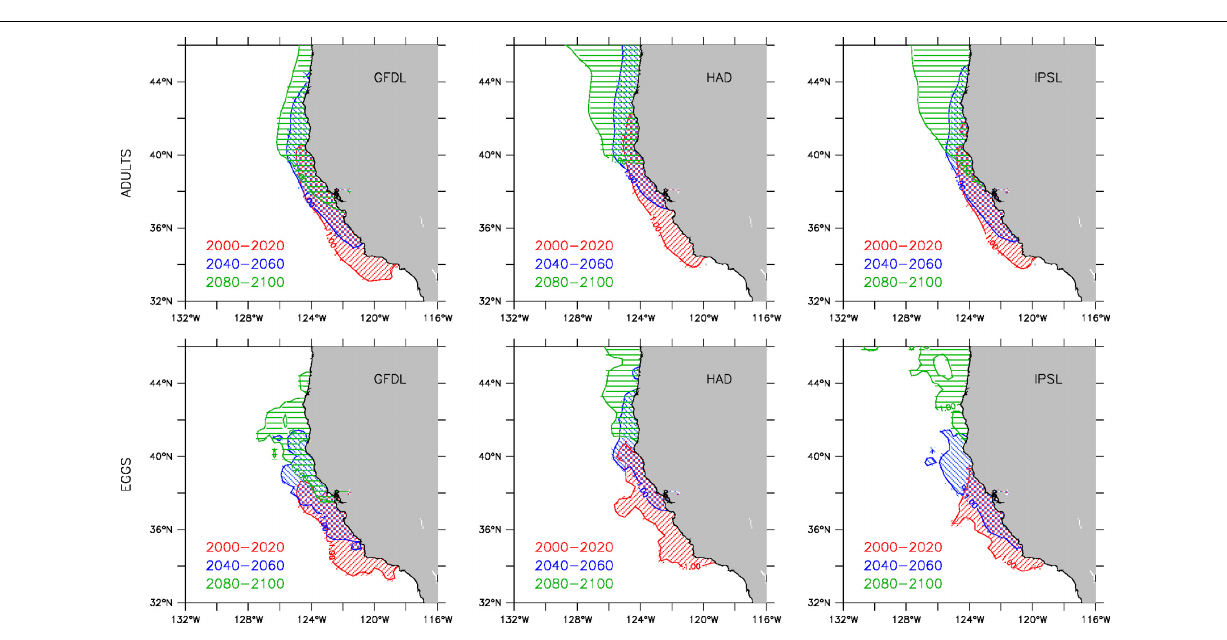
FIGURE 4 | Projected spatial distributions of peak adult sardine abundance (top) and egg production (bottom) for 2000–2020 (red), 2040–2060 (blue), and 2080–2100 (green) from GFDL (left) , Hadley (center) , and IPSL (right) solutions. Regions of peak adult abundance and egg production are defined as locations where individual and egg counts are greater than one standard deviation above the mean (based on all locations where individuals and eggs were